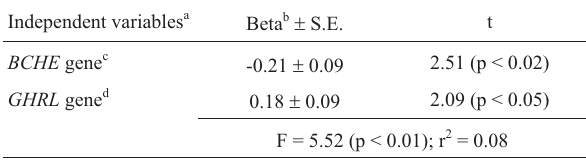
Table 1 - Results from step-wise multiple regression analysis that consid- ered butyrylcholinesterase activity as dependent variable in obese individ- uals (N = 130).